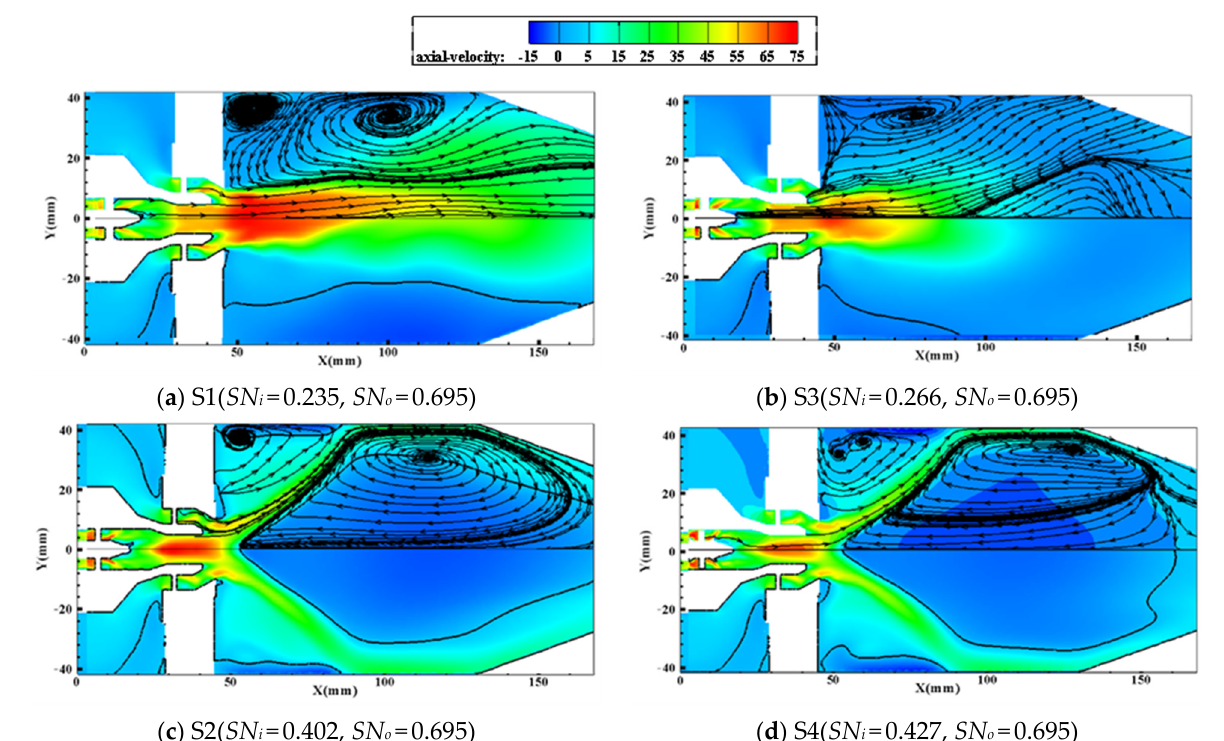
Figure 5. Axial velocity contour and streamline of Scheme S1–S4.